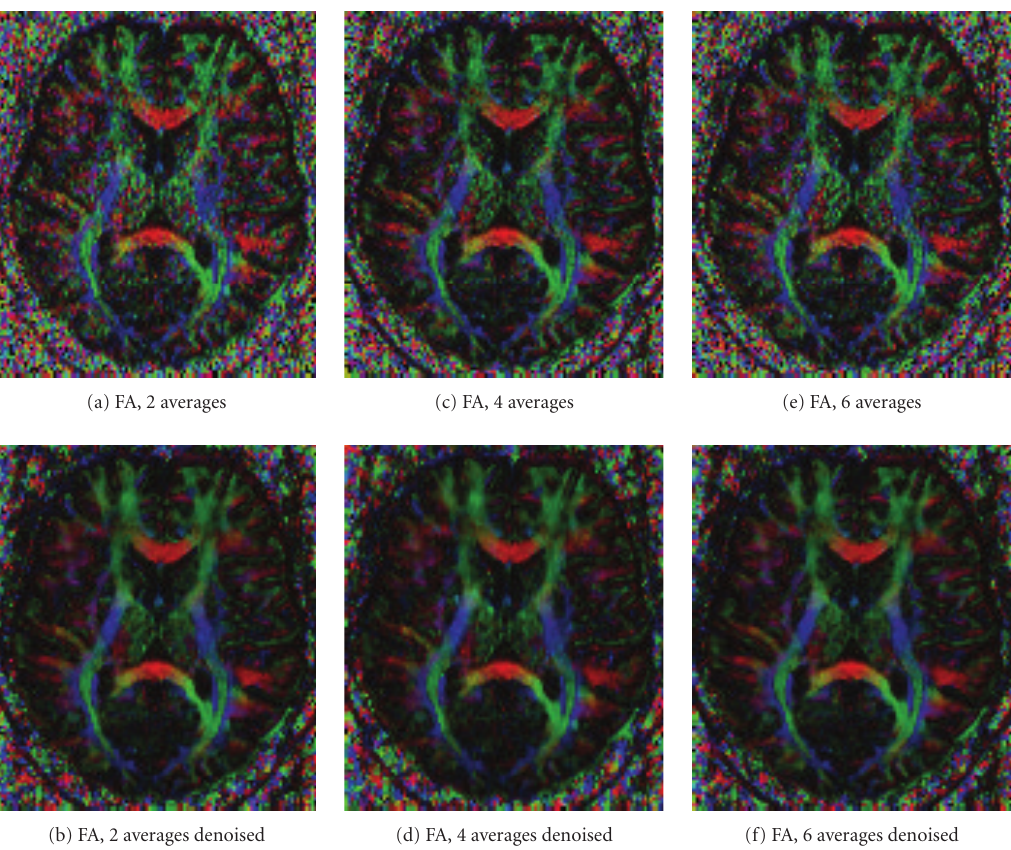
Figure 7: Color-coded fractional anisotropy (FA) maps constructed from averages of two (a), four (c), and six (e) acquisitions, and the corresponding denoised maps (b), (d), and (f).